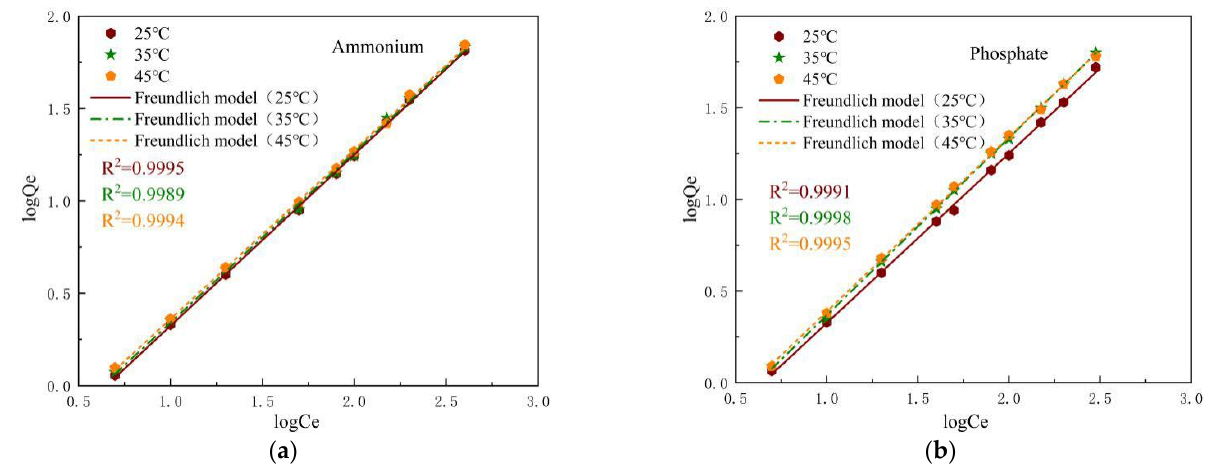
Figure 13. Freundlich isotherm plots for the adsorption of ammonium ( a ) and phosphate ( b ) onto the SOD.